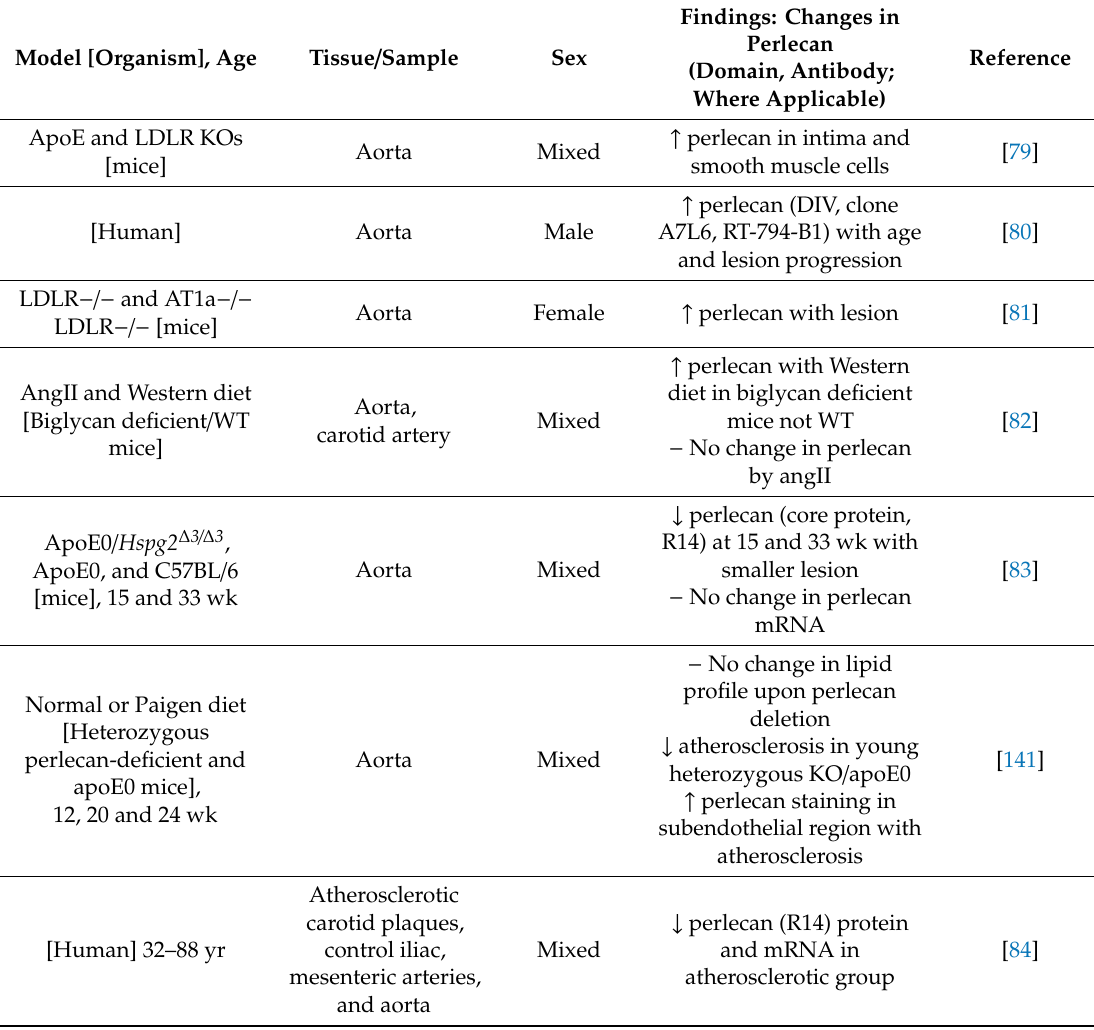
Table 2. Atherosclerosis and